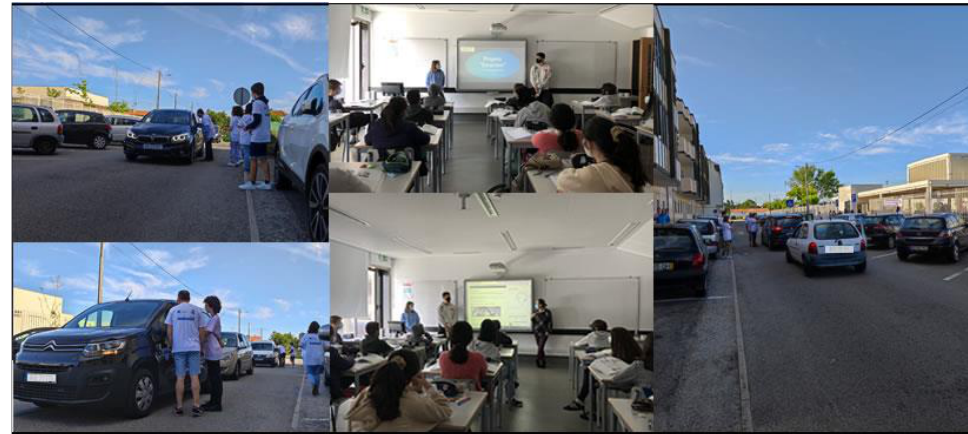
Figure 14. SmartAir community awareness sessions.